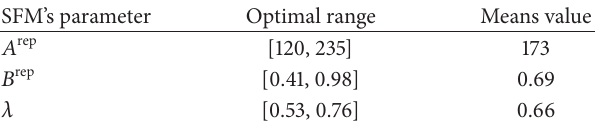
Table 3: Optimal SFM’s parameter